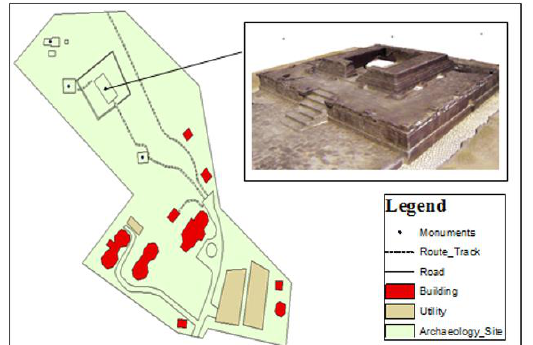
Figure 10: The base map of Bujang Valley archaeological